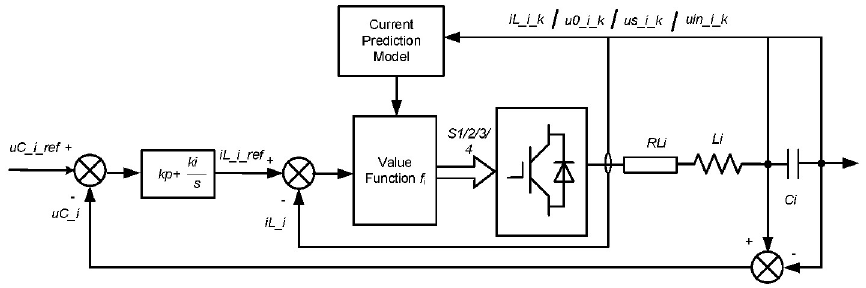
Fig 5. Control strategy of HB-MMC.